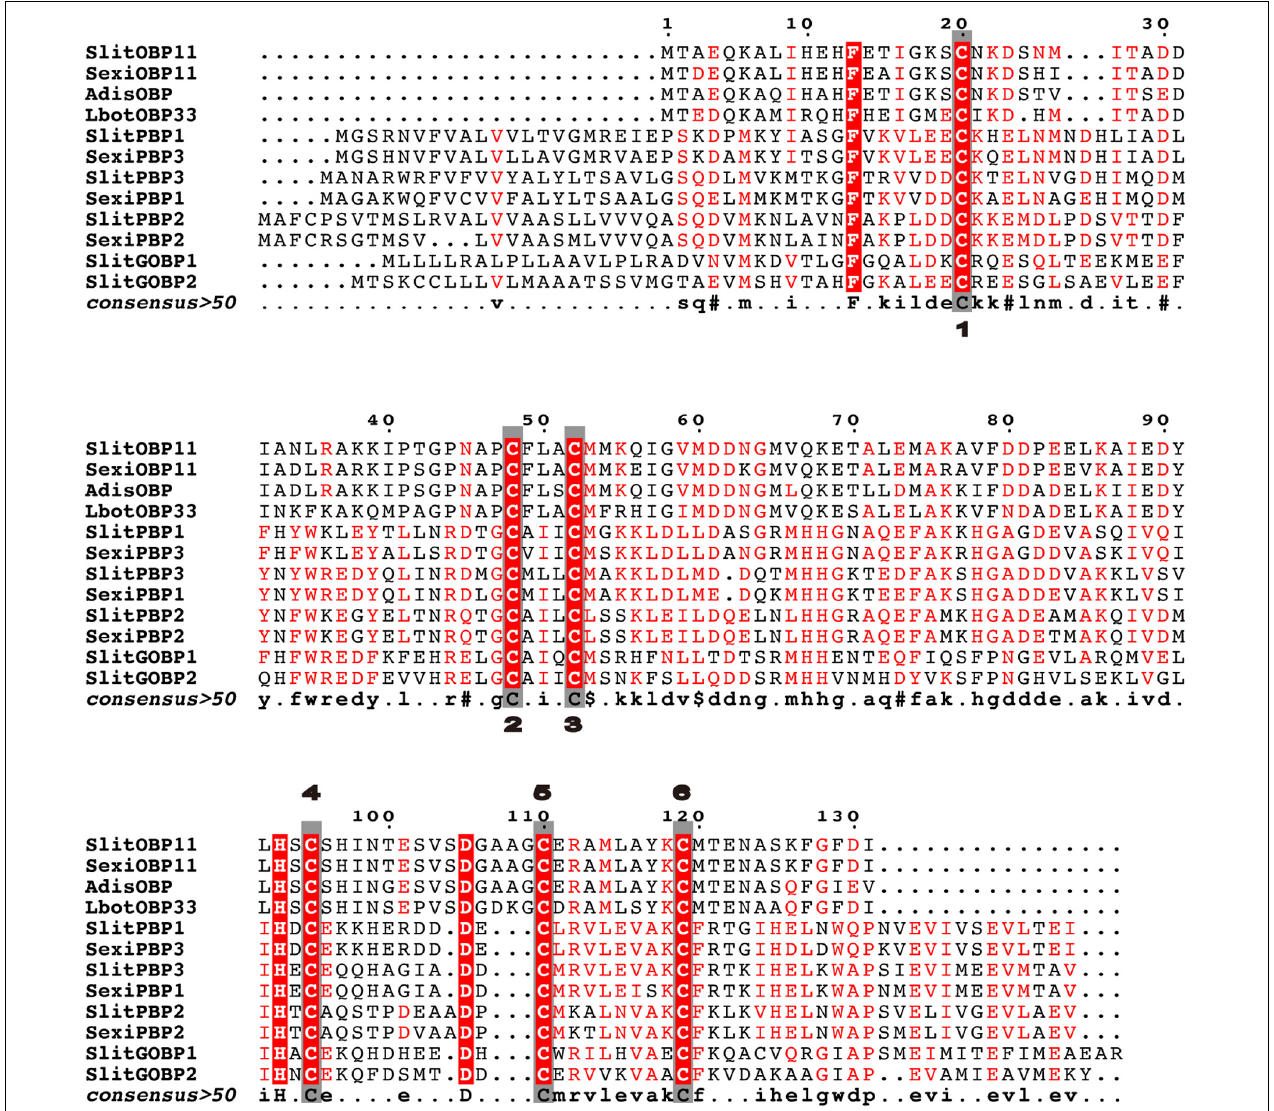
FIGURE 1 | Alignment of SlitOBP11 with SexiOBP11, SexiPBP1, SexiPBP2, SexiPBP3 from Spodoptera exigua , AdisOBP from Athetis dissimilis , and LbotOBP33 from Lobesia botrana . Conserved cysteines are highlighted in the gray box and marked with numbers. The GenBank accession number is XM_022970952.1 for SlitOBP11, AGP03457.1 for SexiOBP11, QCF41969.1 for AdisOBP, AXF48730.1 for LbotOBP33, AKI87957.1 for SlitPBP1, AKI87958.1 for SlitPBP2, AKI87959.1 for SlitPBP3, AKI87960.1 for SlitGOBP1, AKI87961.1 for SlitGOBP2, AAU95536.1 for SexiPBP1, AAU95537.1 for SexiPBP2, and ACY78413.1 for SexiPBP3. The sequences were aligned by Multalin and figure was created by